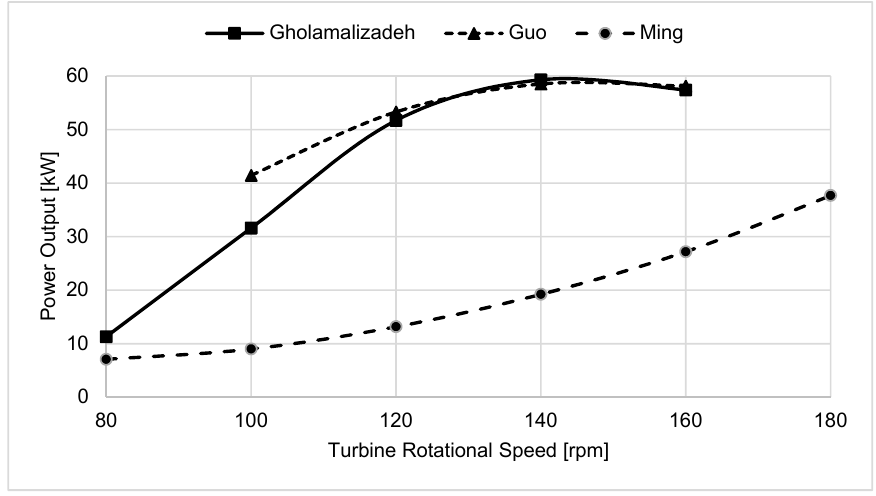
Figure 6. Power output at different turbine rotational speeds.